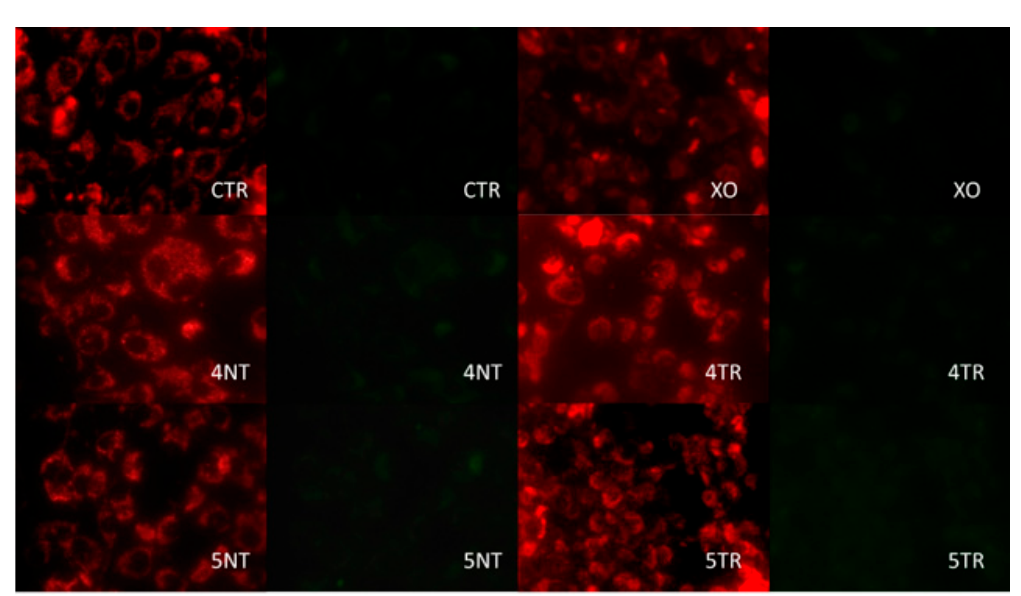
Figure 2. Fluorescence microscopy. View of the accumulation of mitochondrial staining in red and green 24 h after seeding (40× magnification).